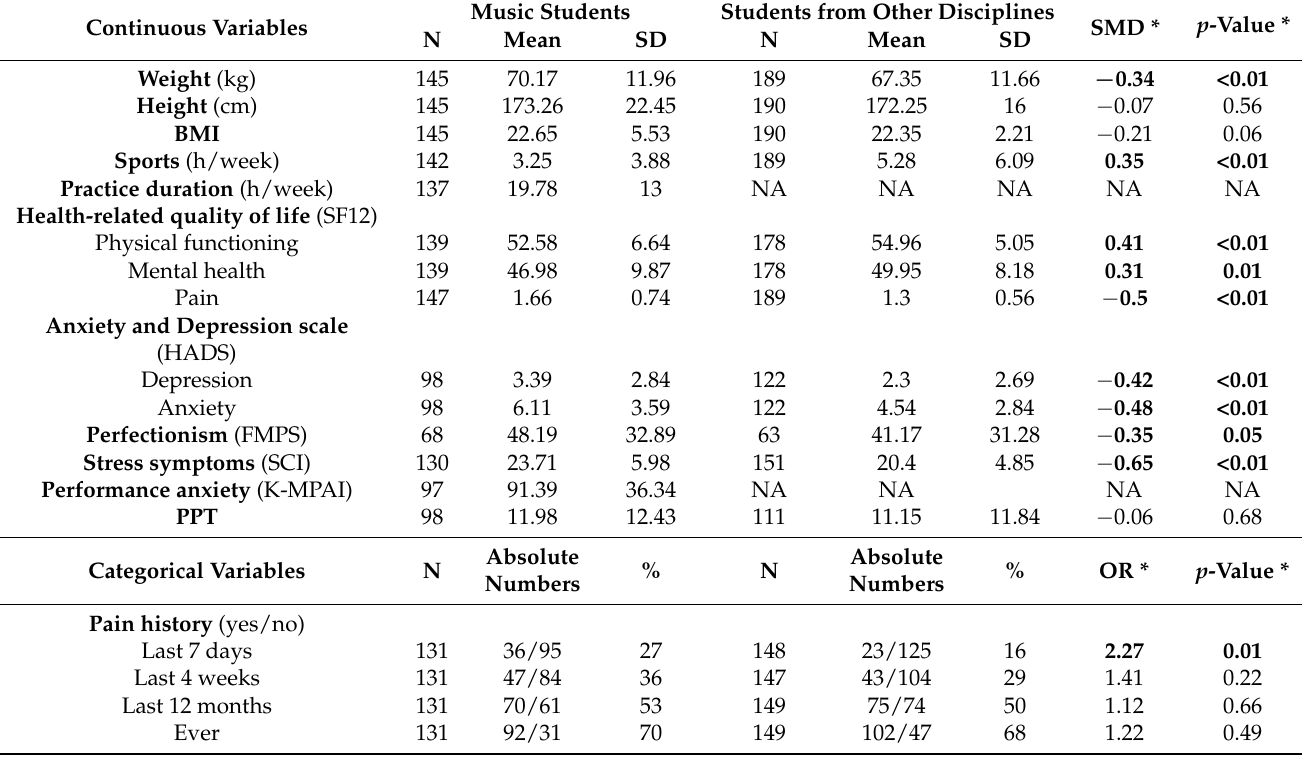
Table 1. Differences between music students and students from other disciplines at baseline (cross- sectional analysis at baseline) represented by standardized mean differences (SMDs) and odds ratios (ORs), respectively, depending on data type (continuous vs.